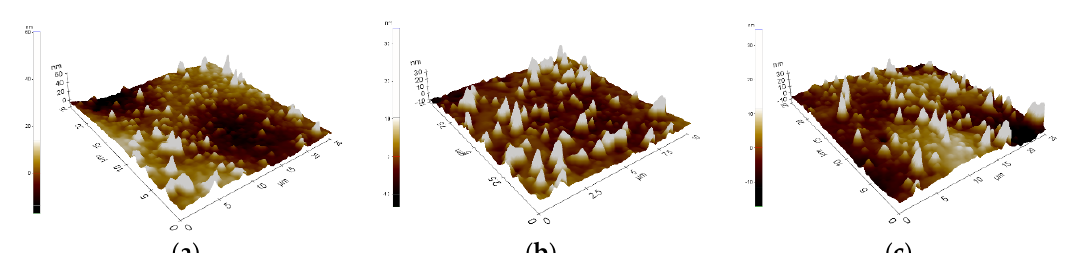
Figure 1. Surface topography of the EOS CoCr removable partial denture (RPD) alloy in its initial state, three-dimensional unevenness diagram, ( a – c )—examples of measure area.